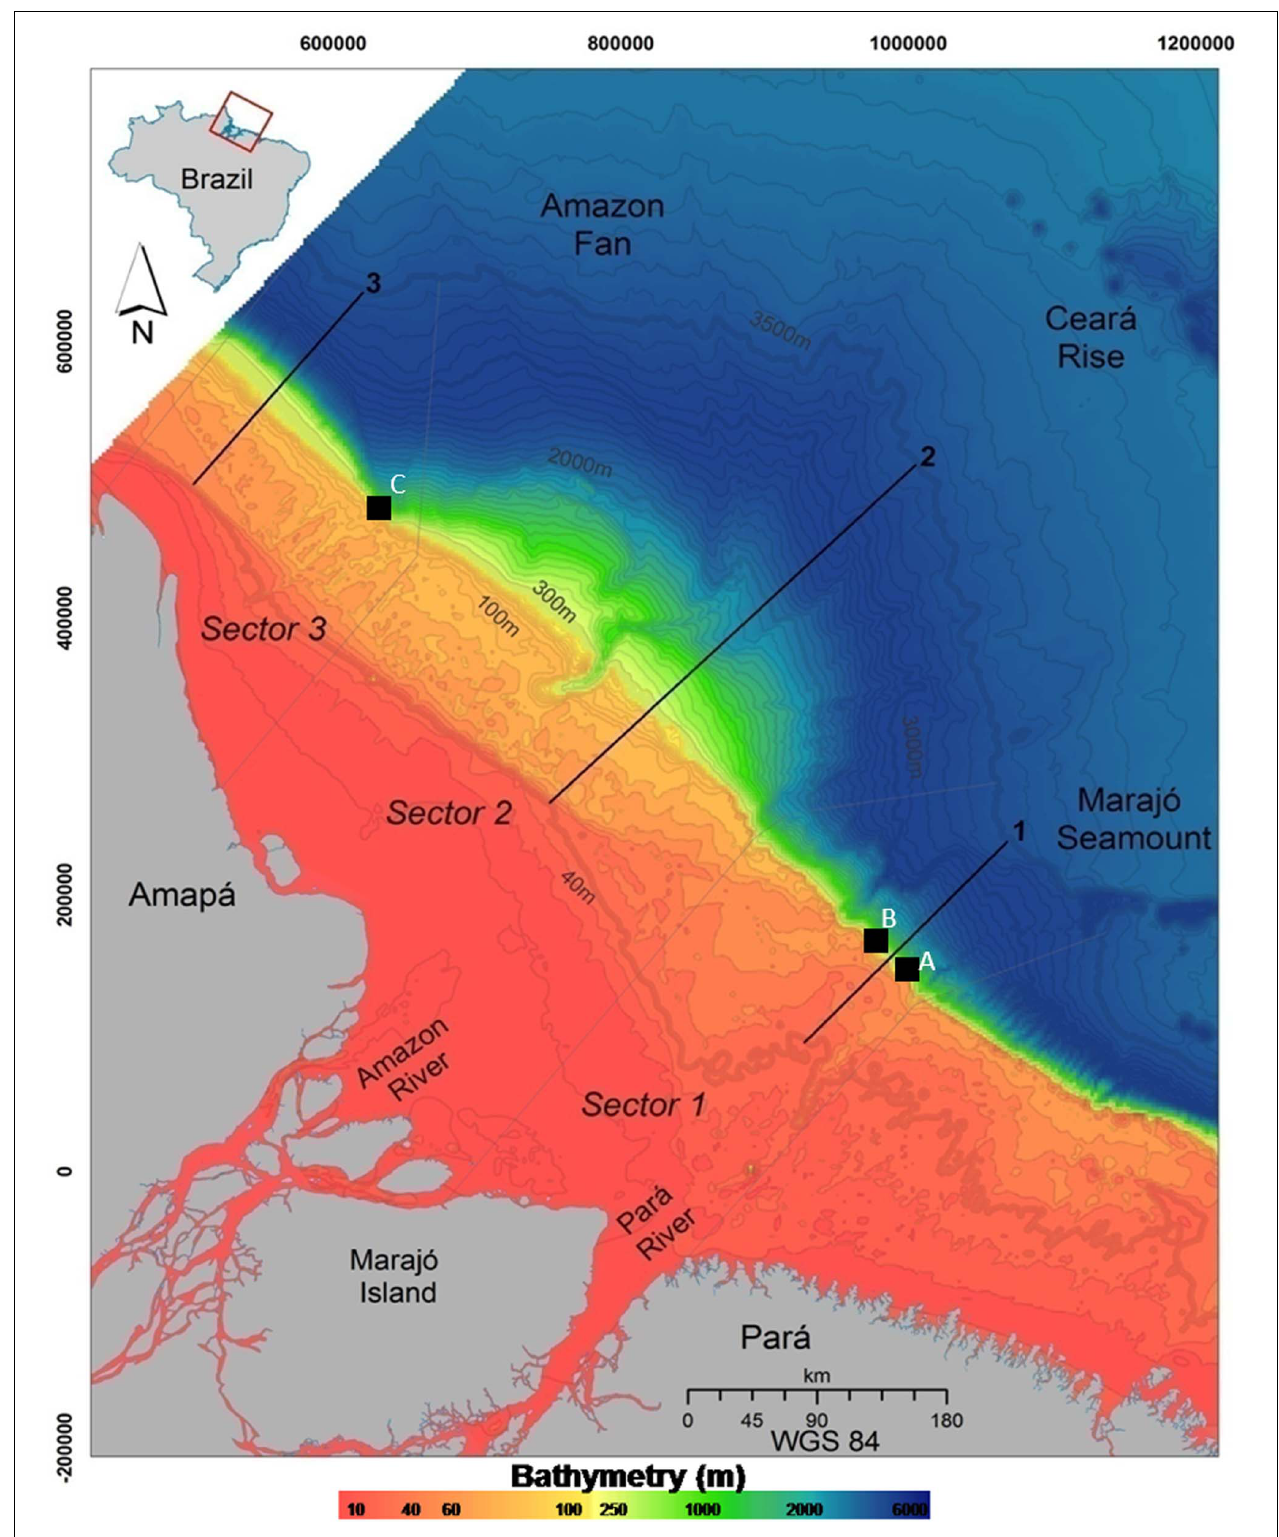
FIGURE 1 | The Brazilian Equatorial Margin (BEM) and the three sectors used in our geomorphometric descriptions. Gray dashed lines are sectors’ borders, and black lines correspond to the longitudinal profiles within each sector (from 40- to 3,500-m water depth, thicker isobaths). Isobaths are spaced at each 10 m (up to 300-m water depth) or 100 m (deeper than 300 m). Black squares indicate the location of Multibeam data acquisition. (A–C) define the 2017 multibeam survey areas along the shelf edge.